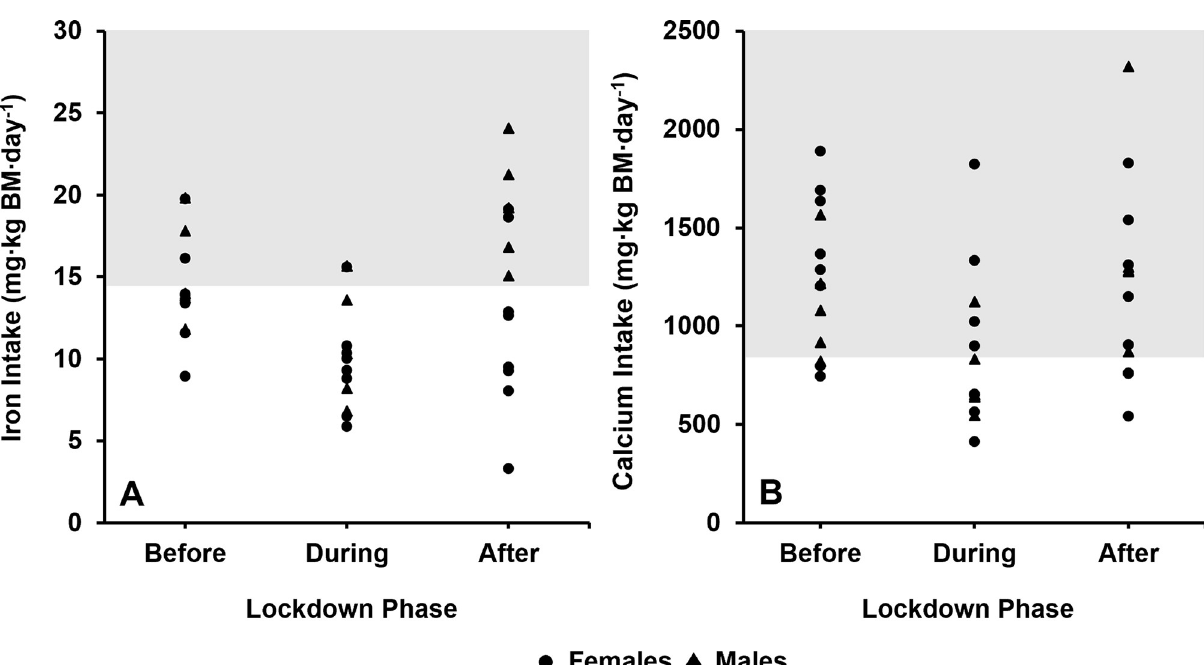
Fig 2. The A) iron and B) calcium intakes of each individual swimmer before, during, and after the COVID-19 lockdown. Grey shaded areas represent the reference nutrient intakes (RNI) recommended for females aged 15–18 years [31]. Note: iron RNI for males = 11.3 mg � day -1 , calcium RNI for males = 1000 mg � day -1